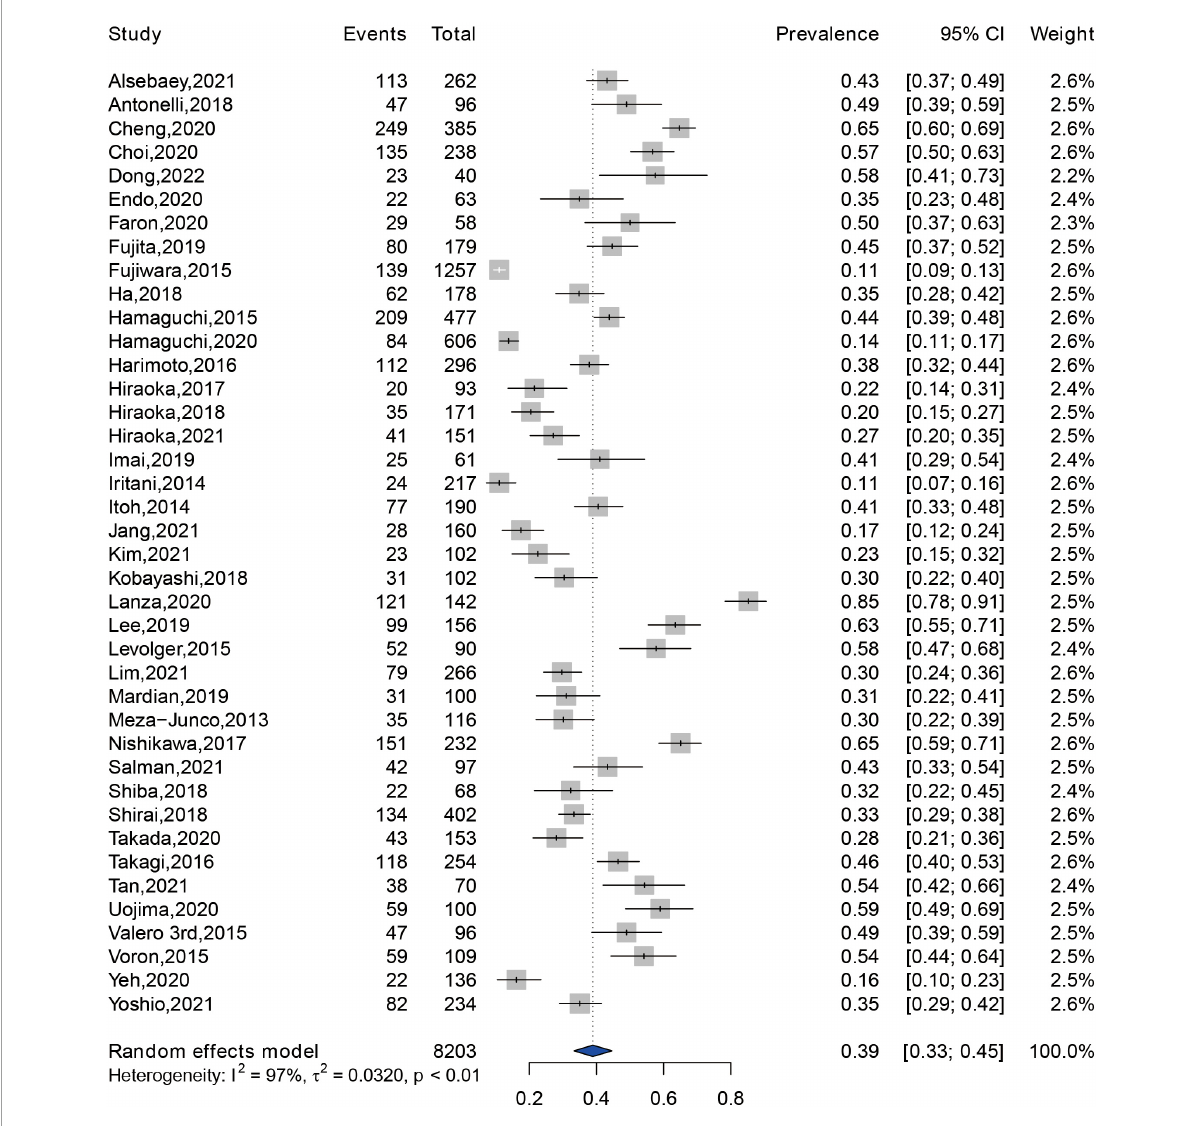
FIGURE2 Forest plot showing the pooled prevalence of sarcopenia among patients with hepatocellular